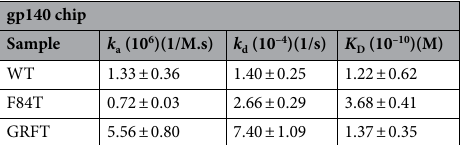
Table 2. Average and standard deviation of kinetics obtained from three replicate SPR experiments measuring the binding response between BG505 SOSIP.664 gp140 trimers and lectins (WT Malay BanLec, F84T Malay BanLec, and GRFT). k a association rate constant, k d dissociation rate constant, K D binding avidity.